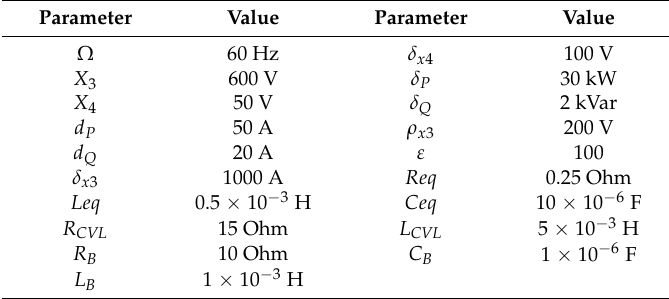
Table 1. Table of